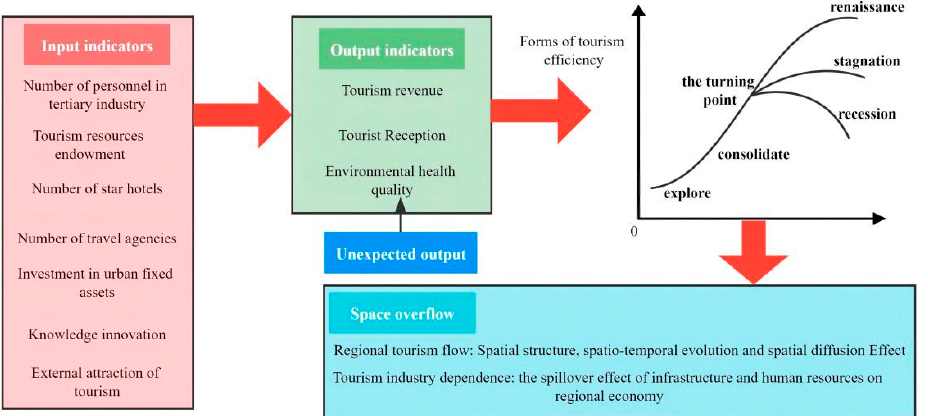
Figure 1. Tourism development efficiency and spatial spillover performance